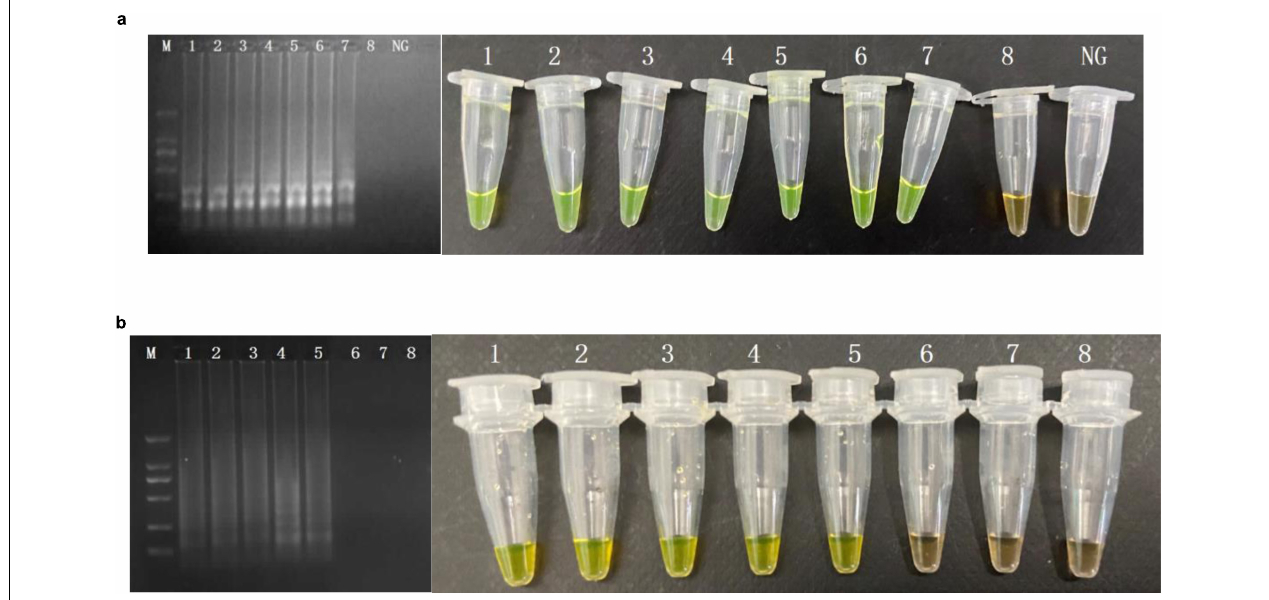
FIGURE 3 | Sensitivity of the CPA by 1.5% agarose gel electrophoresis in food samples of femA (a) , mecA (b) . M, DNA marker; lanes 1–8, 10 7 CFU/ml, 10 6 CFU/mL, 10 5 CFU/mL, 10 4 CFU/mL, 10 3 CFU/mL, 10 2 CFU/mL, 10 1 CFU/mL, 1 CFU/mL.; NG, negative control.